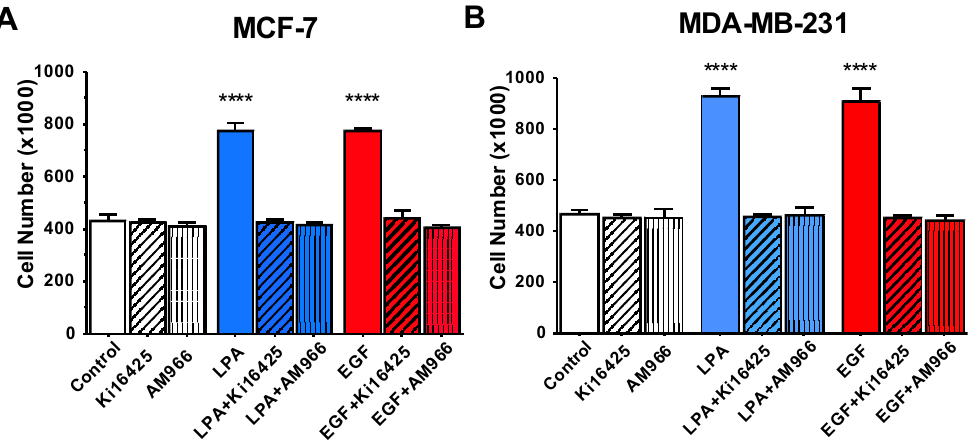
Figure 4. Effects of LPAR antagonists on breast cancer cell proliferation. Serum ‐ starved MCF ‐ 7 ( A ) or MDA ‐ MB ‐ 231 ( B ) cells were incubated with or without 10 μ M LPA or 10 nM EGF in the absence and presence of 10 μ M AM966 or 10 μ M Ki16425. Each data point represents the mean ± SEM ( n = 4) of values (number of live cells per well) from two separate experiments, each performed with two separate replicate wells of cells for each experimental condition (**** p < 0.0001 compared to control). The 48 ‐ h time is point shown; similar results were obtained at 24 and 72 h. Data analysis was performed using two ‐ way ANOVA, followed by Tukey’s multiple comparisons test.